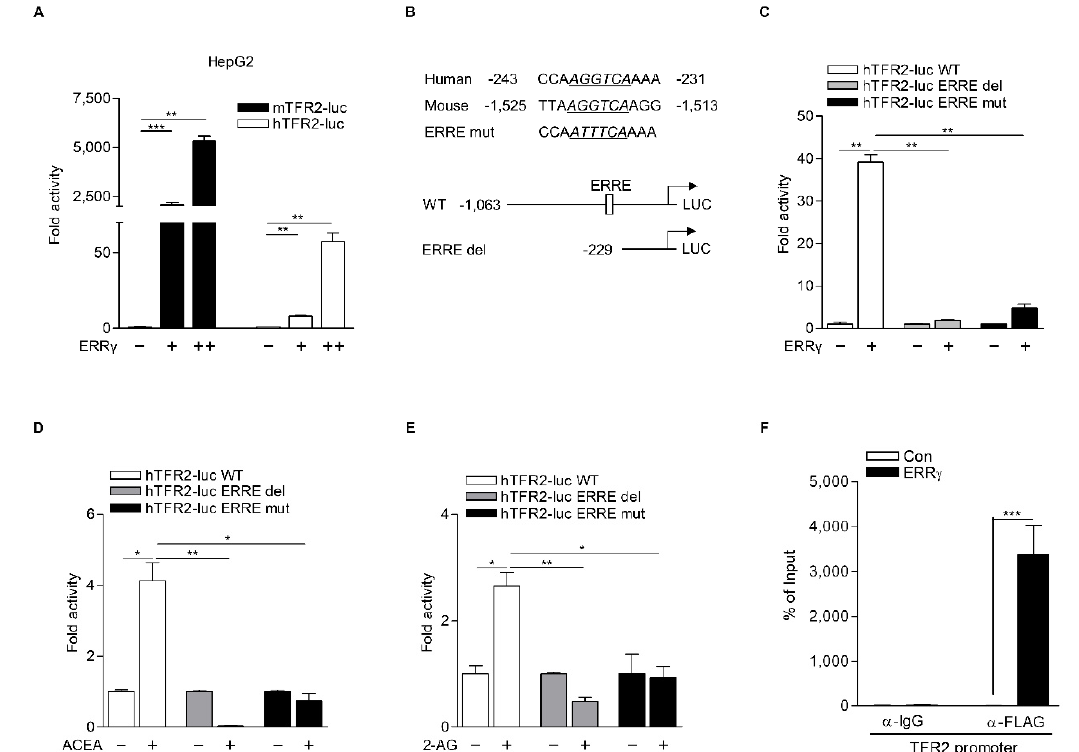
Figure 5. ERR γ directly upregulates TFR2 gene transcription. ( A ) ERR γ activates both mouse and human TFR2 gene promoter. HepG2 cells were transiently transfected with a luciferase reporter vector carrying mouse TFR2 promoter (mTFR2-luc) or human TFR2 promoter (hTFR2-luc) along with expression vector for ERR γ (+: 100 ng, ++: 300 ng) for 48 h. ( B ) Alignment of ERR-response element (ERRE) on human and mouse TFR2 promoter ( top panel ). ERRE sequences were italicized and underlined. Mapping of deletion constructs of hTFR2 promoter ( bottom panel ). WT: wild-type; del: deletion. ( C ) HepG2 cells were transfected with hTFR2-luc WT, hTFR2-luc del, or hTFR2-luc ERRE mut along with an expression vector for ERR γ (+: 300 ng) for 48 h. ( D , E ) HepG2 cells were transfected with hTFR2-luc WT, hTFR2-luc del, or hTFR2-luc ERRE mut for 48 h and then treated with ACEA (10 μ M) ( D ) or 2-AG (10 μ M) ( E ) for 6 h. ( F ) ChIP assay showing the occupancy of ERR γ on the ERRE of the hTFR2 promoter. HepG2 cells were transfected with expression vector for FLAG-ERR γ for 48 h. Soluble chromatins were then immunoprecipitated with an anti-IgG or an anti-FLAG antibody. Ten percent of soluble chromatins were used as input. All experiments were performed in duplicate ( A , C – E ) or triplicate ( F ) and repeated at least twice. Error bars show ± S.D. * p < 0.05, ** p < 0.01, *** p < 0.001 by two-tailed Student’s t -test.